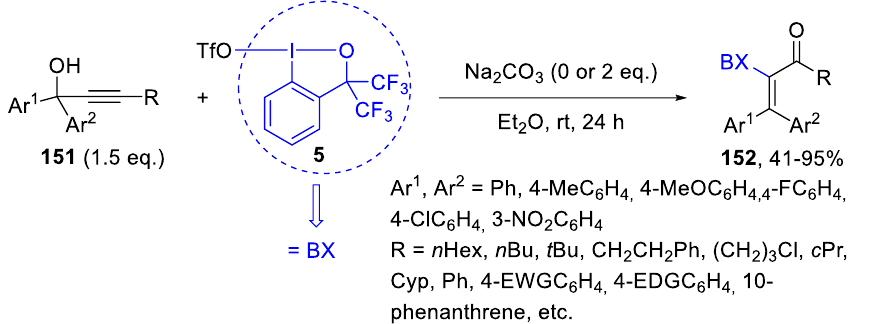
Scheme 31. Synthesis of vinylbenziodoxoles 152 from the benziodoxole triflate 5 and propargylic alcohols 151